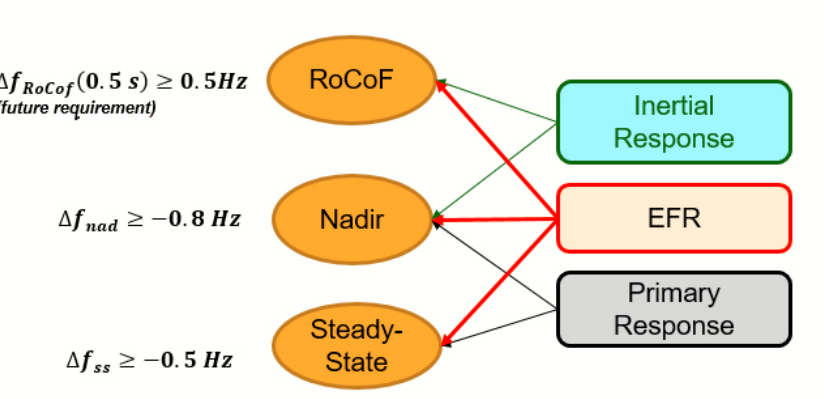
Figure 1. Post-fault transient frequency conditions and security thresholds (left-hand side) associated with the relevant ancillary services (right-hand